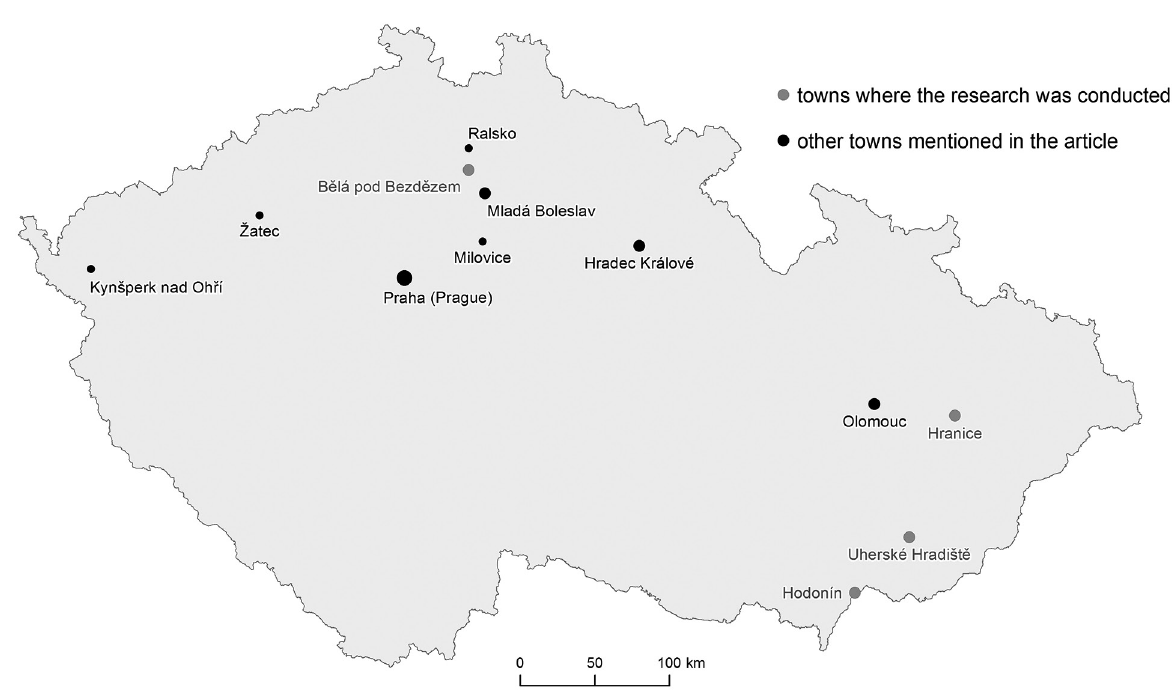
Fig. 3. locations mentioned in the article Source: authors’ own compilation